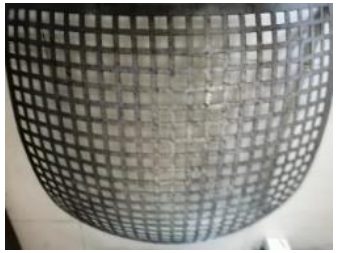
Figure 4. The deformed holes after stamping.